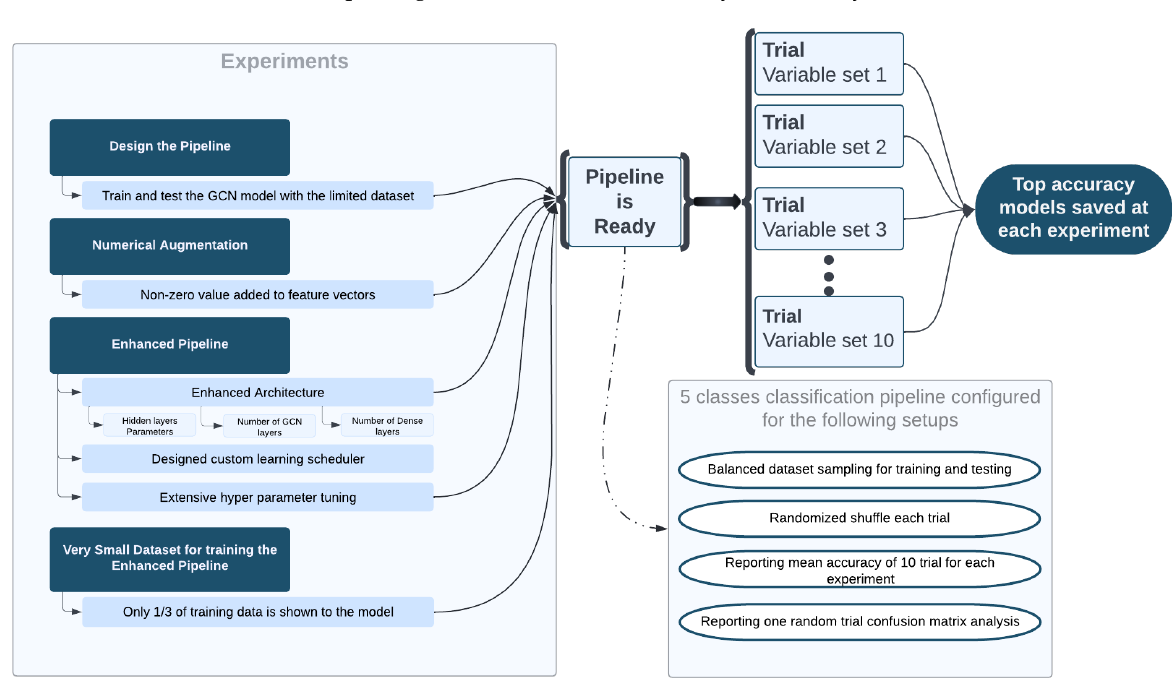
Figure 16. Block diagram of the experiments anatomy of the pipelines for describing the progress until developing the finally used best